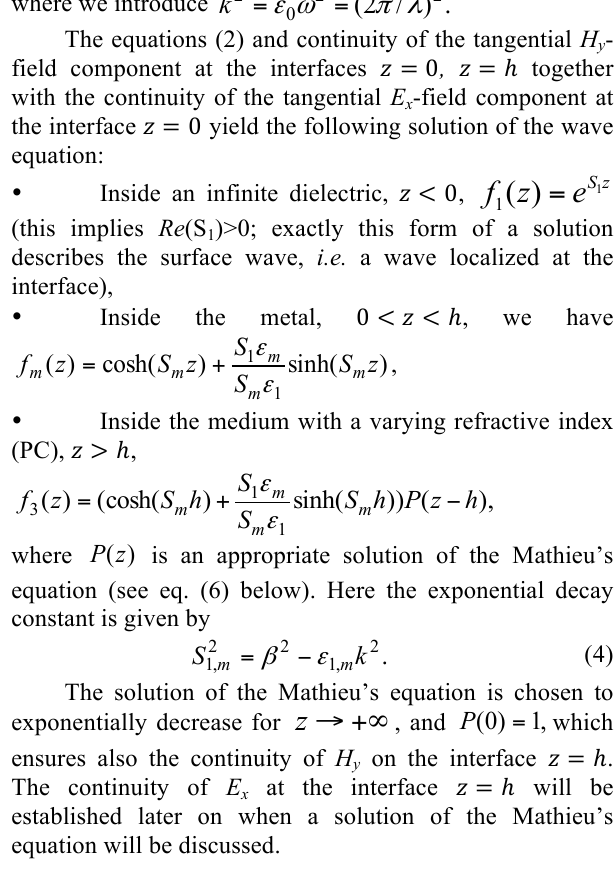
Figure 1. A schematic of the studied structure (not to scale): dielectric ( z < 0 ) − metal ( 0 < z < h ) − photonic crystal ( z > h ). The dielectric constants are respectively; the last two correspond to the dielectic constants of the alternating layers of the photonic crystal with the period L . The bold red line depicts the electric field intensity distribution of a surface wave in the structure, the dashed line images the metal layer boundary. The surface wave propagates along the